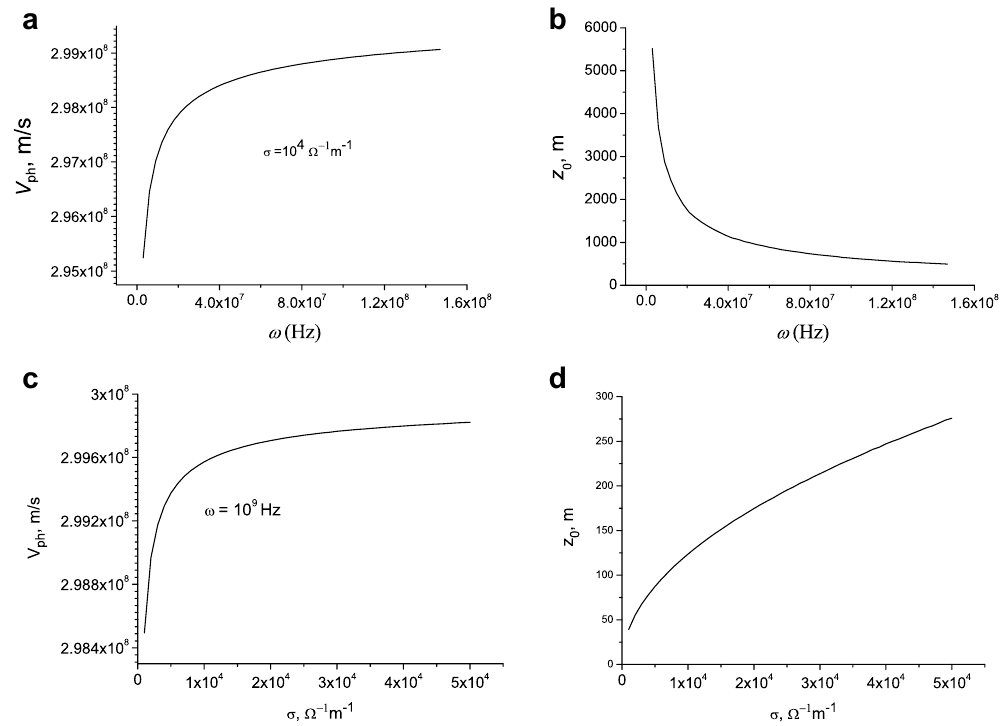
Figure 7. Velocity (panels a and c) and attenuation length (pabels b and d) as function of frequency and conductivity: r 0 = 0.01 m. ( a , b )-σ = 10 4 (cid:31) −